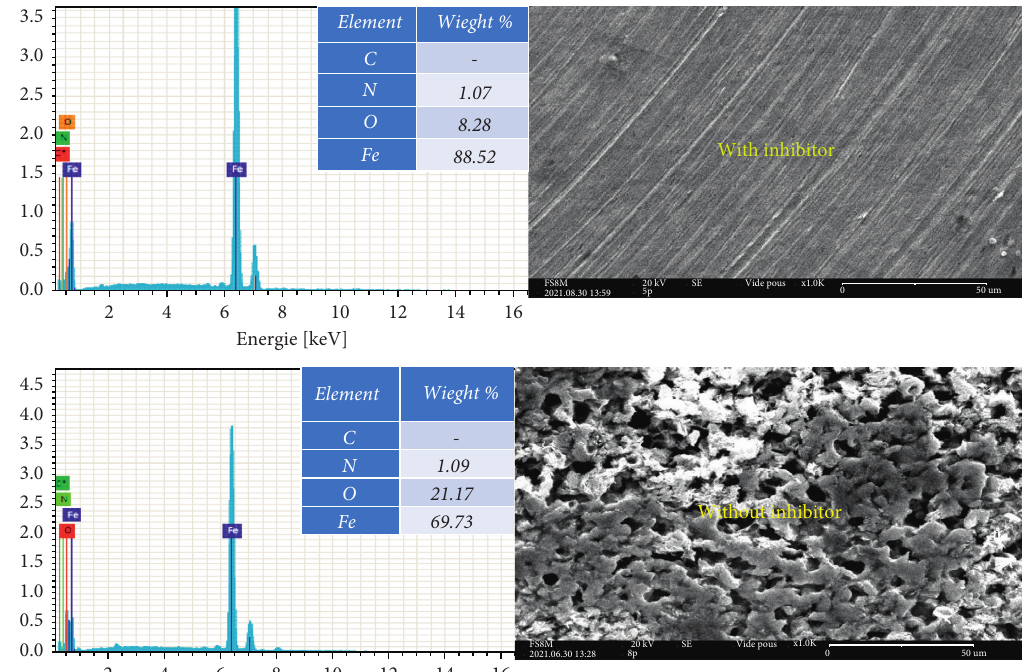
Figure 9: SEM image of the surface with an inhibitor and without an inhibitor (EW) of carbon steel with EDX spectra corresponding to each